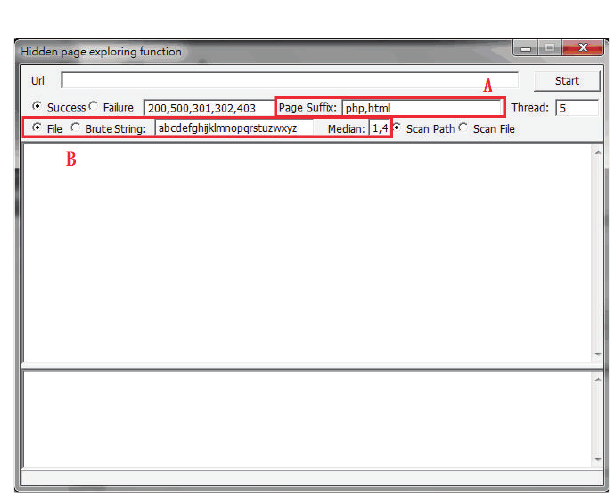
Figure 9: Interface for hidden page scanning.